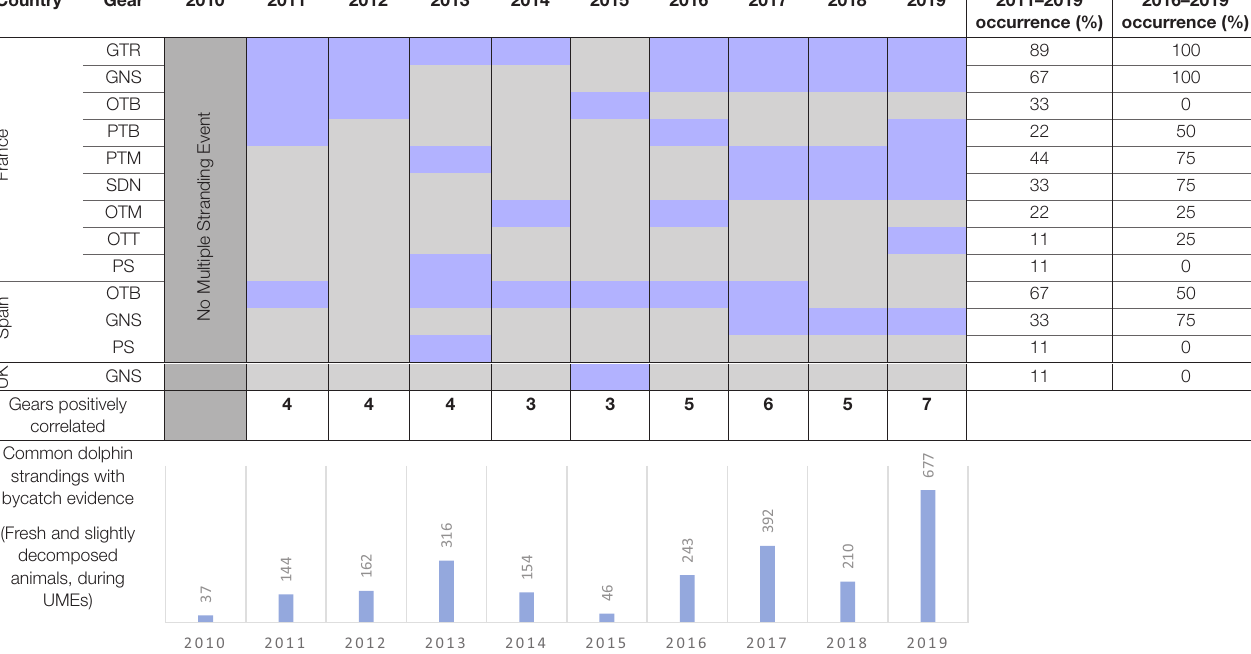
TABLE 5 | Time series of positive correlations (in blue) between fishing effort and origin of bycaught common dolphins in ICES subareas 27.8.a and 27.8.b (2010–2019). Country